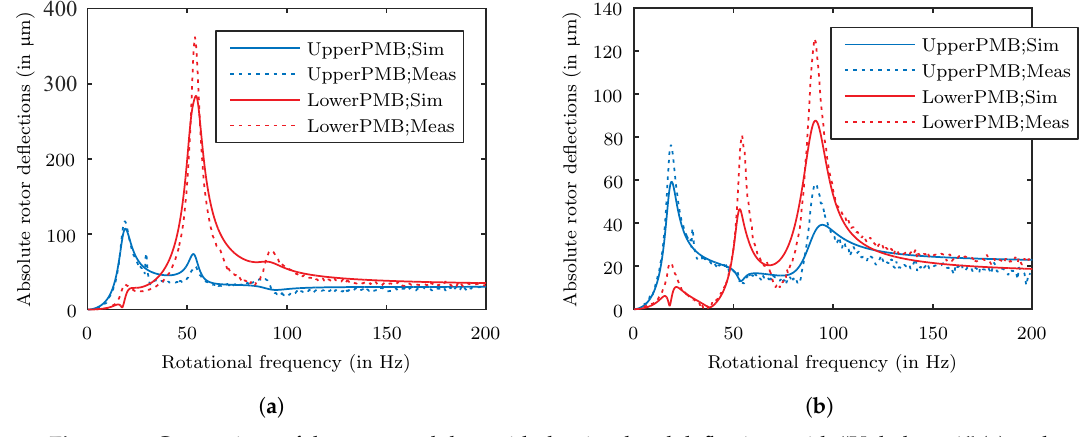
Figure 15. Comparison of the measured data with the simulated deflections with “Unbalance1” ( a ) and “Unbalance2” ( b ) specified in Table 4 considering the lower PMB stiffnesses and a adopted temperature of 37 ◦ C for the upper damping